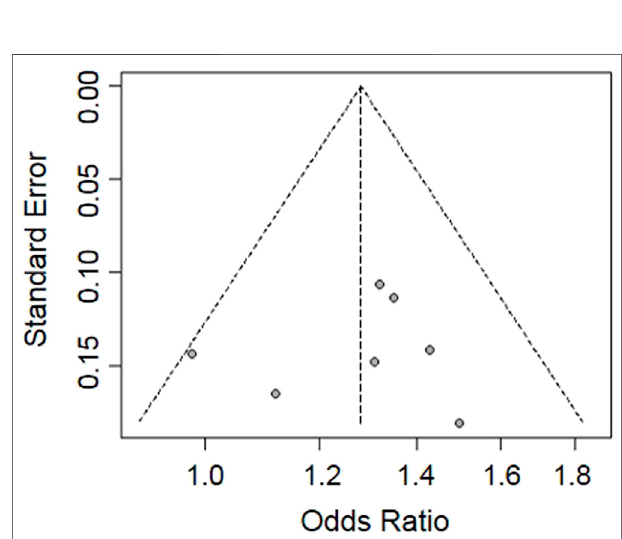
FIGURE4| Funnelplotforpublicationbiasanalysisoftheeligiblestudies evaluating the relationship between rs1564282 polymorphism and the risk of PD. The x- axis and y- axis represent the ORs and standard errors for every eligible study, respectively.